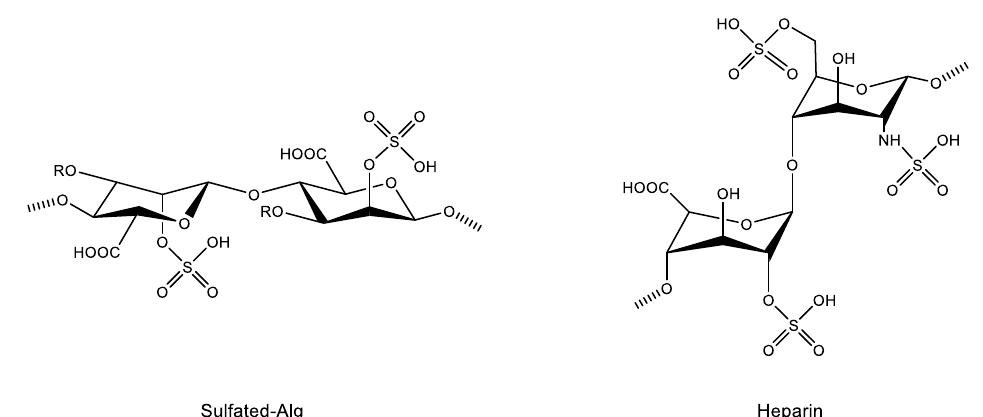
Figure 6. Structural resemble between sulfated alginate with heparin.